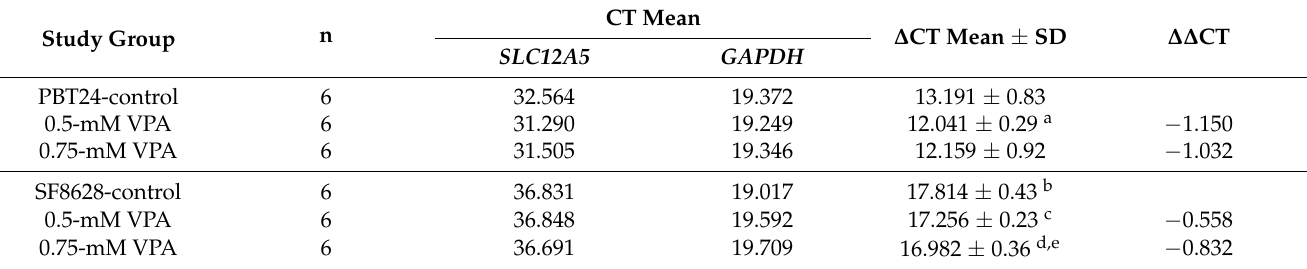
a p = 0.0087, compared with PBT24-control; b p = 0.0022, compared with PBT24-control; c p = 0.0022, compared with PBT24-0.5 mM VPA; d p = 0.0260, compared with SF8628-control; e p = 0.0022, compared with PBT24-0.75 mM